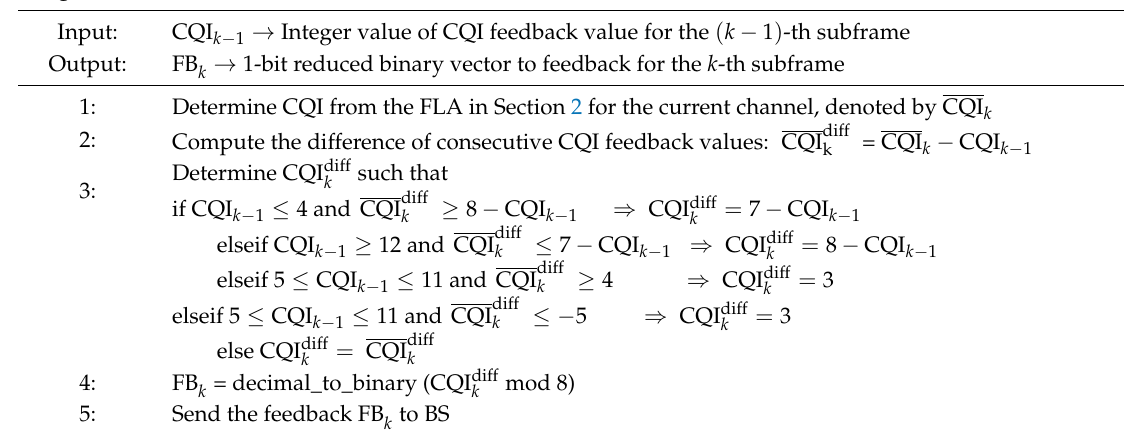
Algorithm 3 The 1-bit reduction scheme of CQI feedback at each user